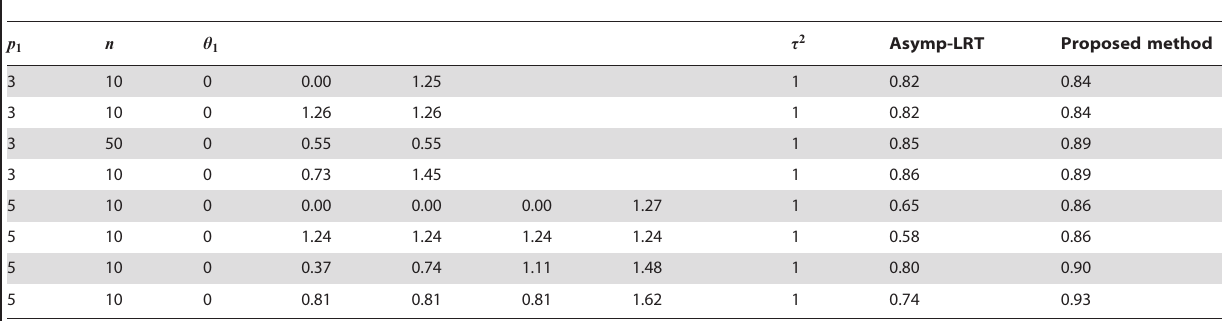
Table 2. Power for homoscedastic normally distributed data.